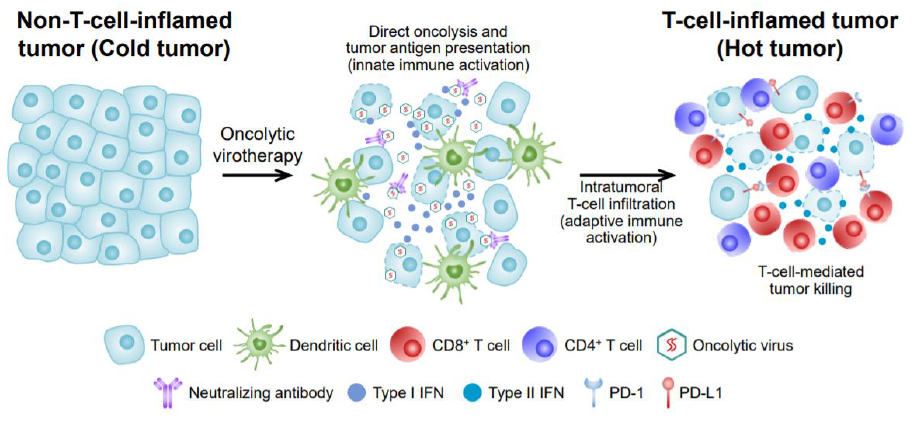
Figure 1. Mechanisms of oncolytic virus (OV) anti-tumor effects.